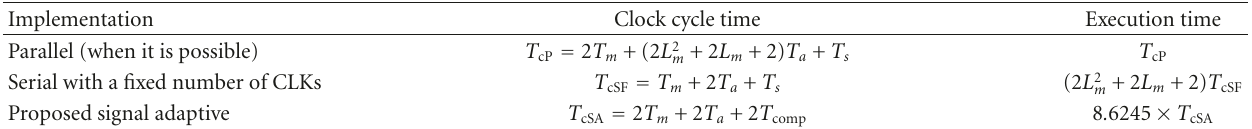
Table 9: CLK cycle times and execution times (by frequency-frequency point) of the considered implementations of 2D systems. T cP , T cSF , T cSA are CLK cycle times in the cases of the parallel design, MCI one with a fixed number of CLKs and the signal adaptive one, respectively, whereas T s is the 1-bit shift time. Execution time of the proposed design has been calculated for the considered signal (5) and N = 64, L m = 5. Total number of CLKs taken by the proposed design is 35326, whereas the average number of CLKs by frequency-frequency point is 35326/64 2 =